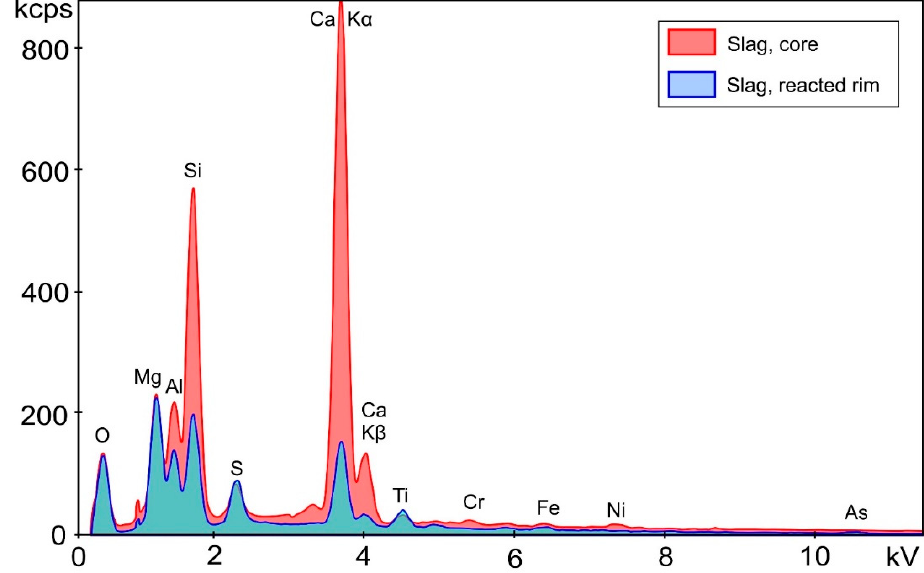
Figure 2. Energy-dispersive X-ray spectroscopy (EDX) spectrum of the unreacted core of Ca-Mg-Al- silicate (slag) and the EDX spectrum of the reaction rim. Based on these, data suggest the reaction rim is depleted in Ca, Al, and Si in comparison with the core, which presumably relates to growth of ettringite on the grain boundary (see text for more details).